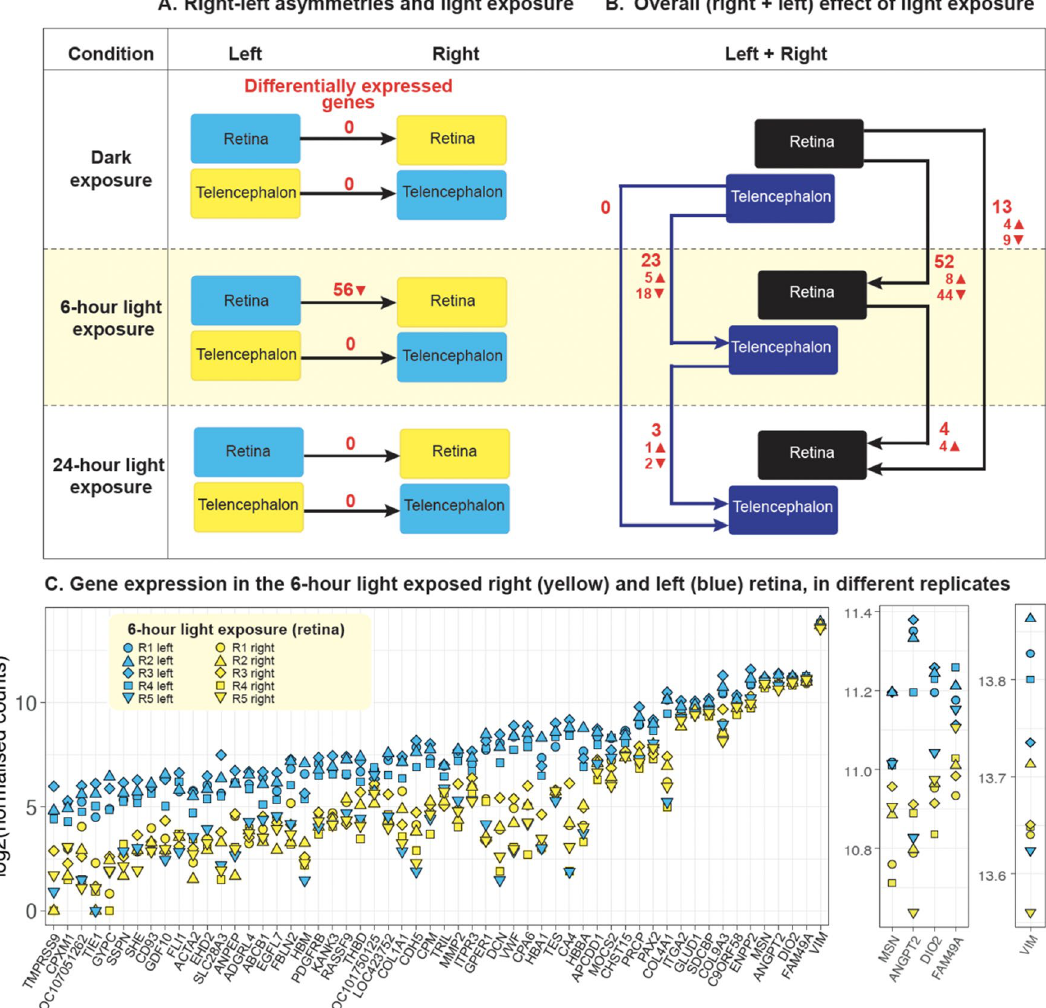
Figure 2. ( A ) Diagram of the left–right comparisons and differentially expressed genes (in red) for each comparison (filled triangle—upregulation, inverted filled triangle—downregulation). ( B ) Diagram of the overall (right + left) effect of different exposure to light (darkness, 6-h, 24-h) as differentially expressed genes (in red) in the retina and telencephalon. ( C) Gene expression. For each gene differentially expressed in the retina at 6-h light exposure, the log2(normalised counts) are shown on the y axis. A supplementary close-up is presented on the right panels for better visualisation of all replicates. Yellow symbols indicate the replicates of the right retina, blue symbols indicate replicates of the left retina. Different symbols indicate different replicas, as shown in the differences 61 . The dissection of retinas and telencephalons were performed in parallel by two experimenters to minimize sample collection time. Brain tissue was macroscopically subdivided in two regions: telencephalon and remainder of the brain. Of these regions, only telencephalon was further subdivided into left and right sam- ples and processed for RNA-seq. Macrodissected brain samples were frozen immediately on dry ice and stored at − 80 °C until RNA extraction. For retina dissection, first, eyelids were cut away and the whole eye was carefully removed without piercing the eye globe. Then, dissection of the retina from the enucleated eyes was performed by cutting the eyes in half to expose the vitreous and retina. The translucent gelatinous vitreous humour was carefully removed with forceps exposing the retina. Retina and pigmented epithelium were removed from the eye cup and placed immediately on dry ice and stored at − 80 °C until RNA extraction. Molecular sexing. Since anatomic asymmetries in the thalamofugal pathway 75 and behavioural asymmetries 76,77 are more pronounced in male chicks compared to females (reviewed in Ref. 78 ), we focused our study on males only. Sexing was performed according to Ref. 79 . RNA extraction and quality control. Total RNA was extracted and DNAse-treated using RNeasy mini kit (Qiagen) with DNAse treatment, following the manufacturer’s protocol. RNA concentrations were measured